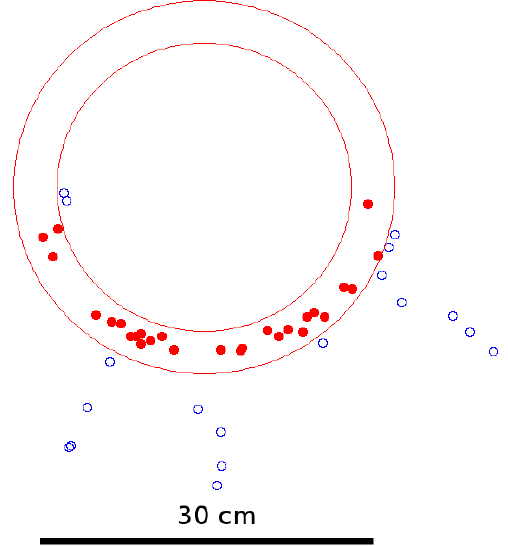
Figure 6. In each iteration in the RANSAC algorithm inliers are found within a given tolerance of the chosen circle. This model is saved for further calculations if the circle is of a valid size, there are few points inside the trunk, and the number of inliers is larger than the previous chosen